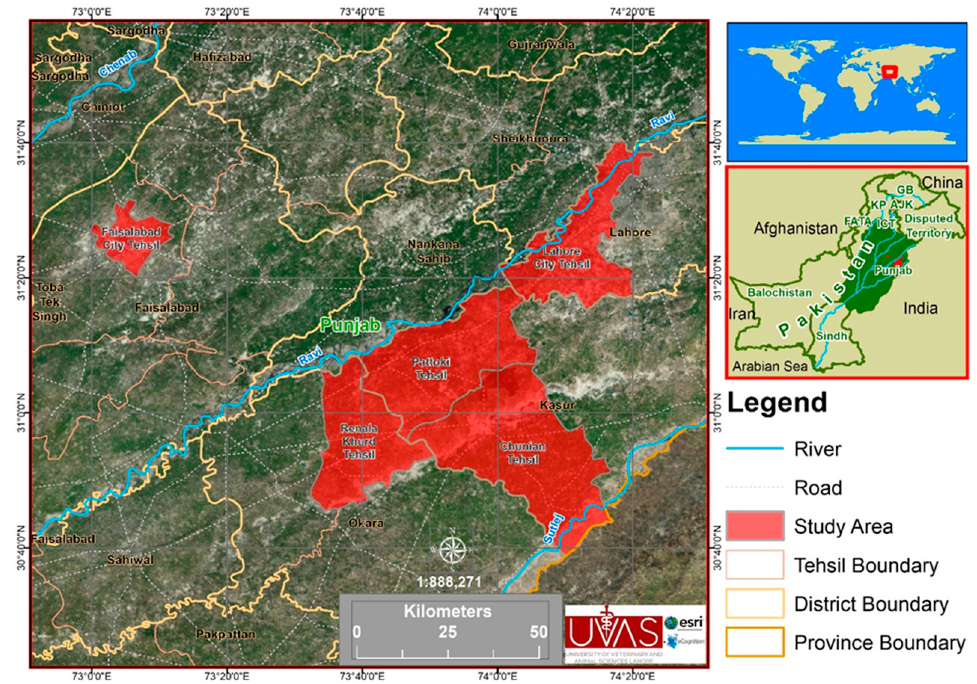
Figure 1. Study area map consisting of five tehsils (Pattoki, Chunian, Renala Khurd, Lahore, and Faisalabad) and four districts (Kasur, Lahore, Okara, and Faisalabad).